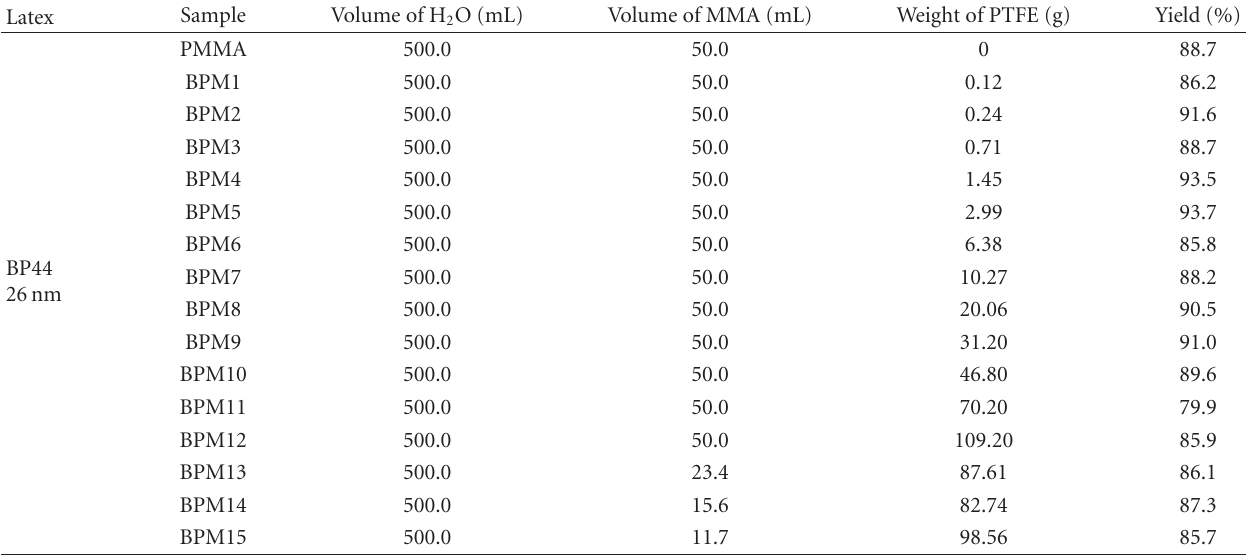
Table 1: Synthesis details and yield of the various